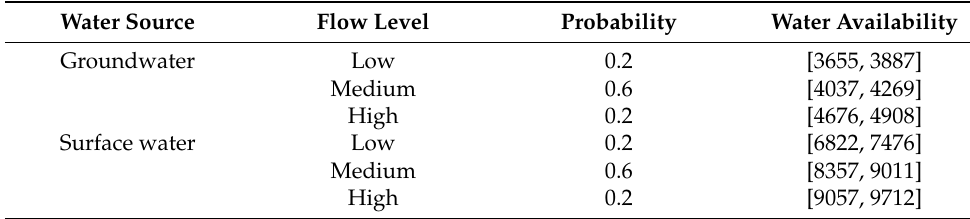
Table 2. Water availability at different flow levels (10 6 m 3 ).